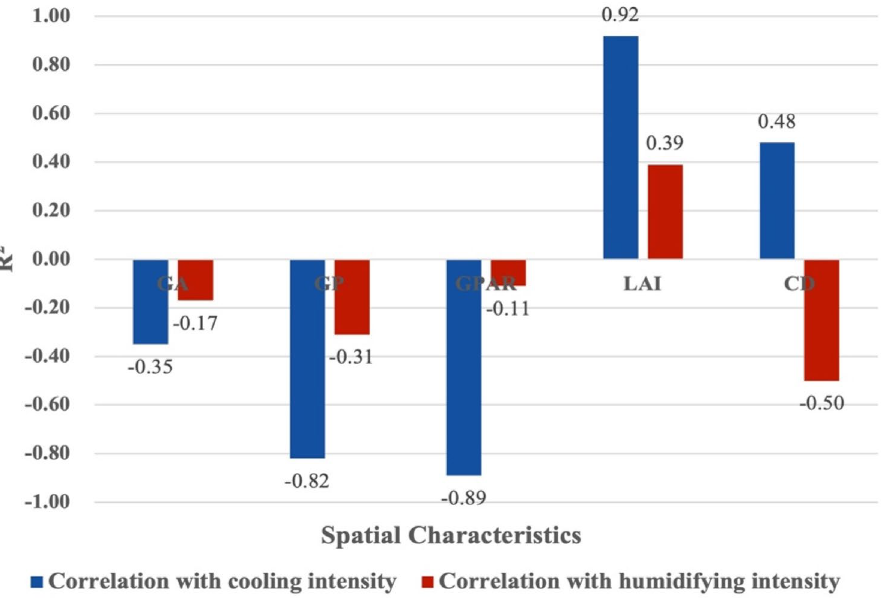
Figure 12. The correlation between the spatial characteristics of large-size green spaces and the intensity of cooling and humidifying (GA means green area; GP means green perimeter; GPAR means green perimeter-area ratio; LAI means leaf area index; CD means canopy